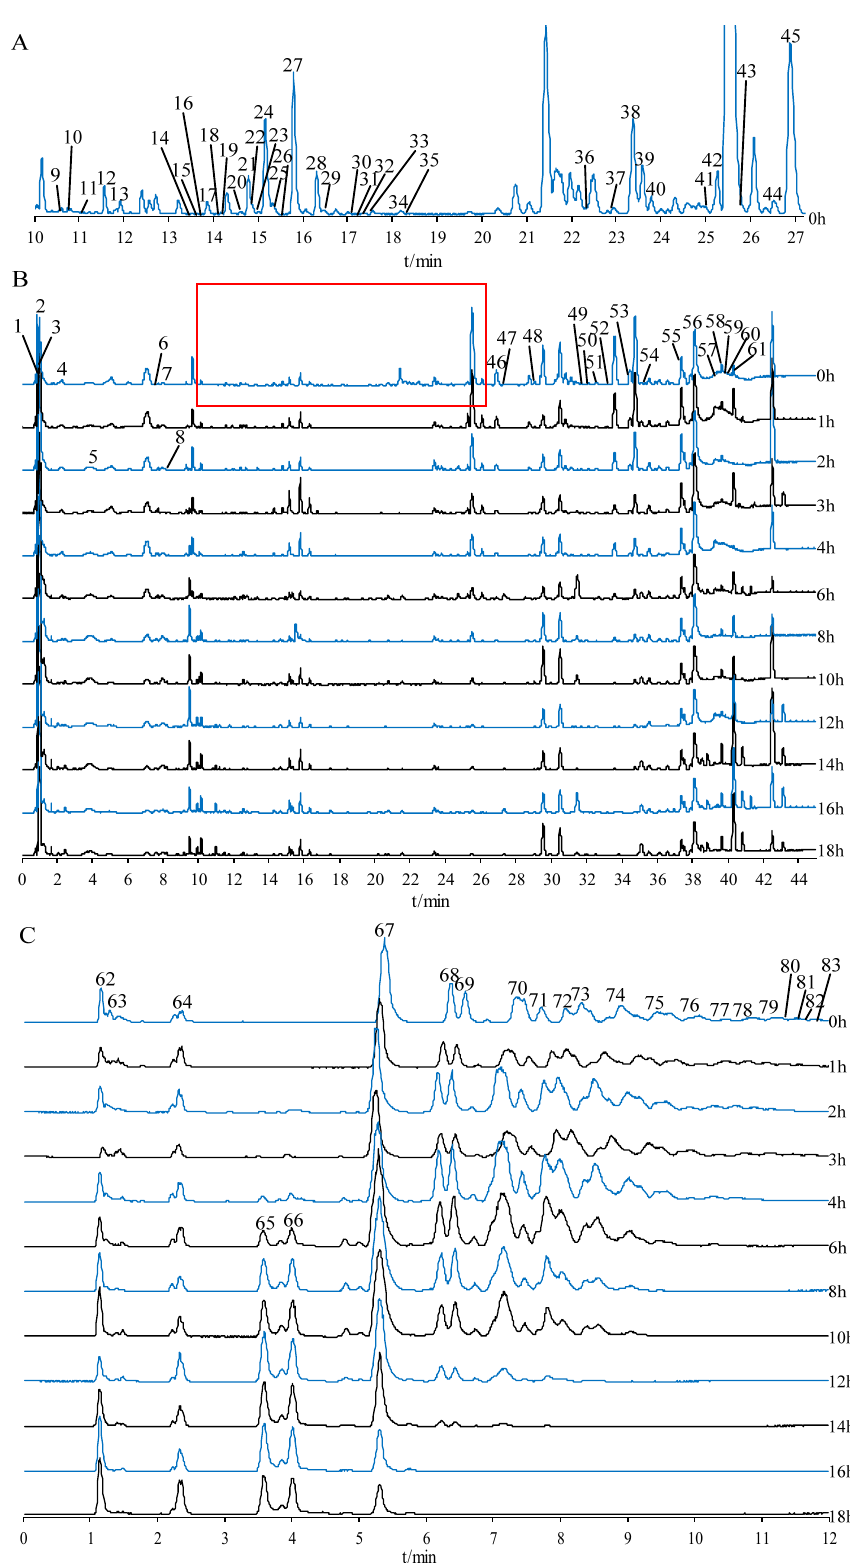
Figure 1. ( A ) Base peak intensity (BPI) chromatogram of secondary metabolites in raw Polygonatum cyrtonema rhizome from 10 to 27 min. ( B ) BPI chromatograms of secondary metabolites in PCR with varying processing times. ( C ) BPI chromatograms of oligosaccharides and monosaccharide derivatives in PCR with varying processing times.